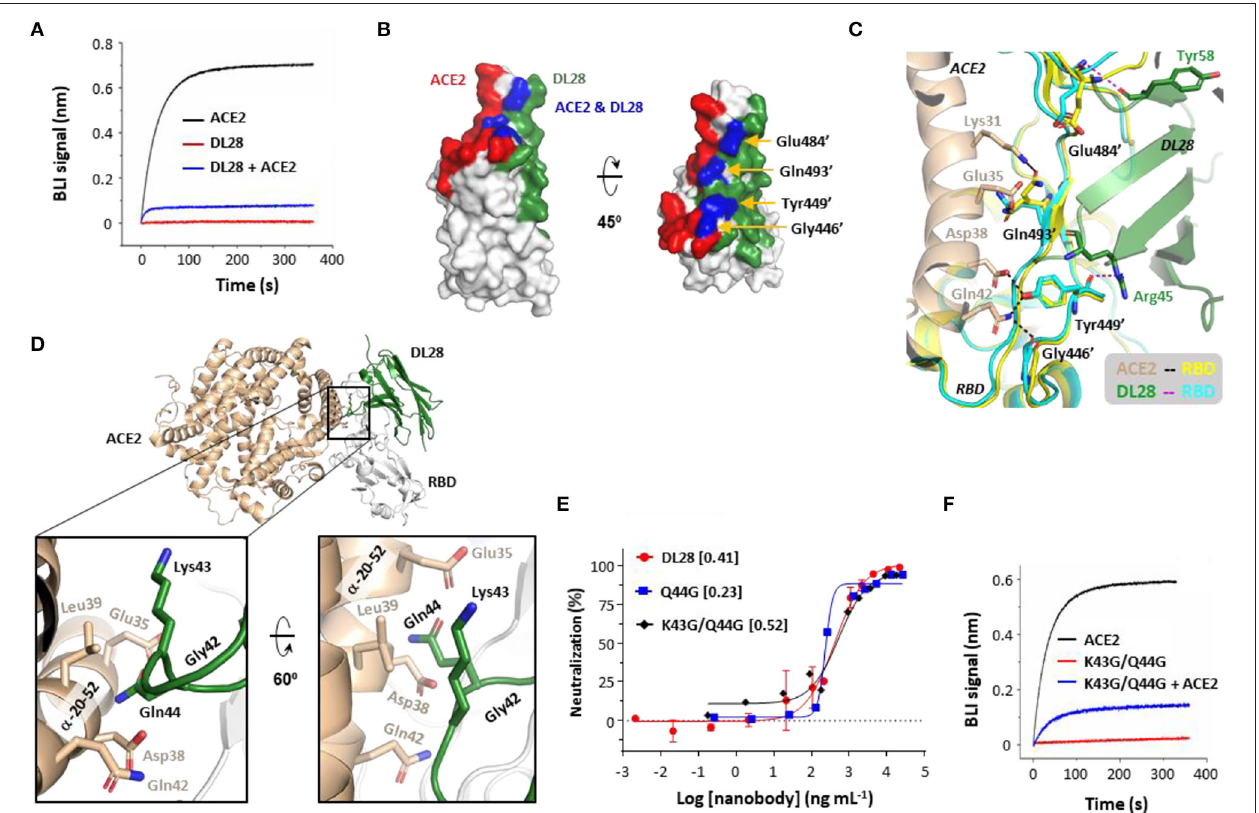
FIGURE 4 | The ACE2-blocking activity of DL28 unlikely involves direct competition or steric hindrance. (A) Pre-incubation of DL28 with RBD blocks ACE2-binding. A sensor coated with RBD was first treated with 100nM of DL28 before being incubated with a DL28-containing solution with (blue) or without (red) ACE2. As a control, the ACE2-RBD binding profile (black) was recorded without DL28 on a biolayer interferometry (BLI) system. (B,C) The overlap (blue) between the DL28 epitope (green) and the ACE2-binding site (RBM, red) (B) is speculated to be compatible for binding with both DL28 and ACE2 (C) . Black/magenta dashed lines indicate ACE2-RBD and DL28-RBD interactions, respectively. (D–F) The minor clashes between DL28 and ACE2 do not play a major role in cross-competition. (D) Gln44 on DL28 is in close contact with the RBD-interacting α -helix from ACE2 when the DL28-RBD structure is aligned onto the ACE2-RBD structure. (E) Neutralization assays for Q44G and K43G/Q44G using the SARS-CoV-2 WT strain. The data for DL28 are obtained from Figure 1E for comparison reasons. (F) The triple-glycine DL28 (Gly42, K43G/Q44G) retained the ability to inhibit ACE2 for RBD-binding. The experimental setting was the same as in (A) . Monovalent DL28 was used in (A) and Fc-dimers were used in (E,F)